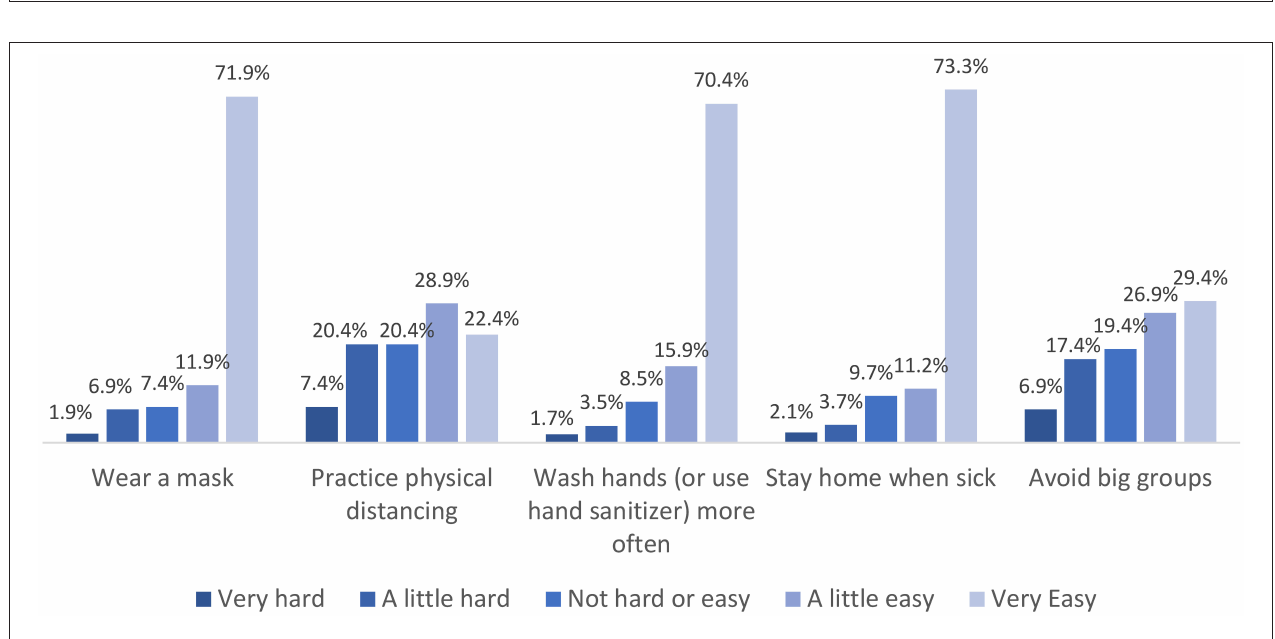
FIGURE 2 | Students’ self-reported ease of practicing COVID-19 safety measures at school.